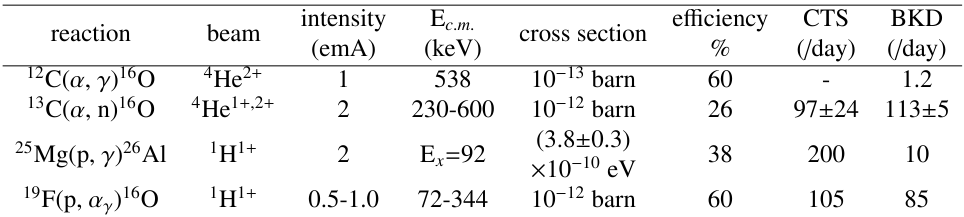
Table 1. Basic parameters of four reactions